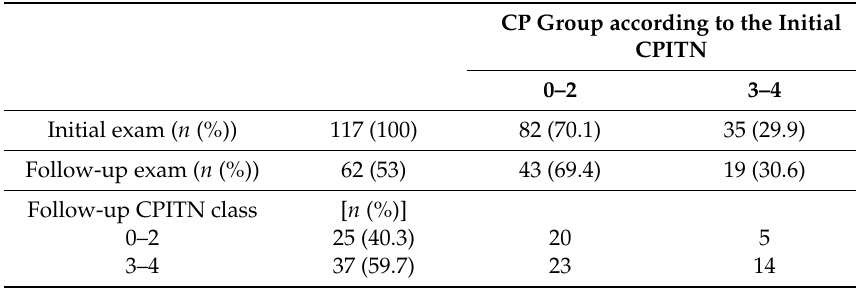
Table 2. Initial and follow-up CPITN values in study patients, in whom the re-evaluation of dental status was performed during the follow-up